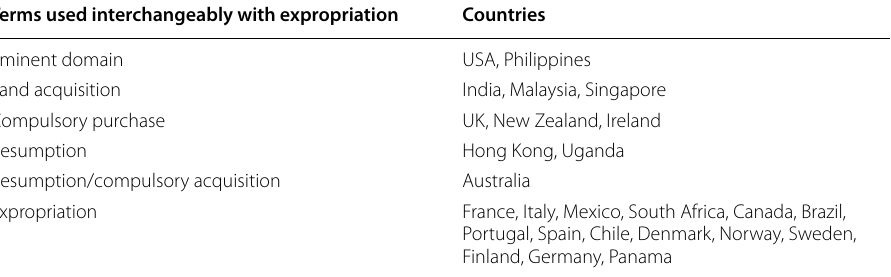
Table 1 Terms used interchangeably with expropriation in different countries Terms used interchangeably with